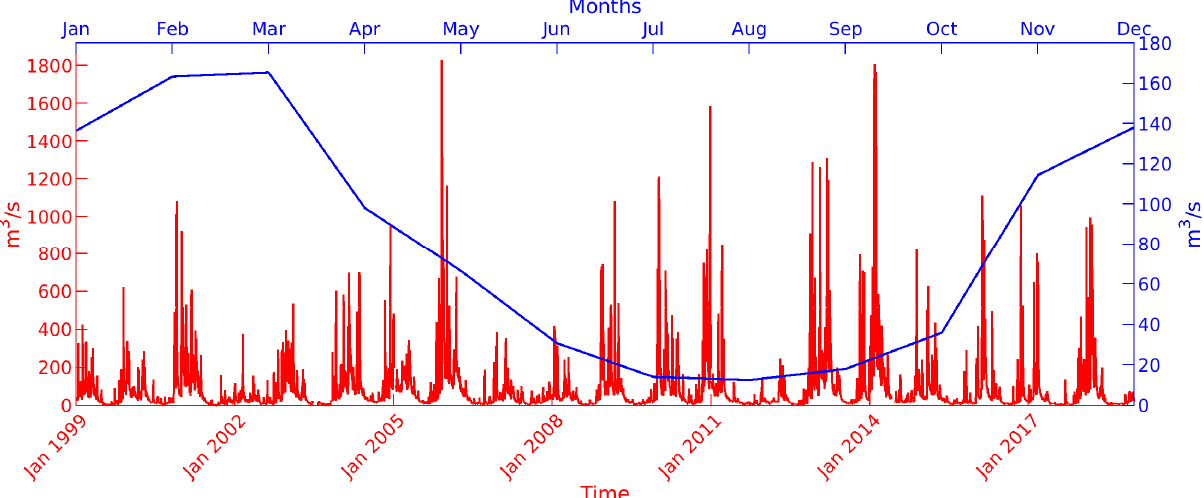
Figure 3. Daily and monthly Arno River discharge values recorded during the period 1999–2018 by the TOS01005191 automatic gauge station managed by the Regional Hydrological Service of Tuscany Region and located close to S. Giovanni alla Vena, approximately 25 km upstream from the river mouth.